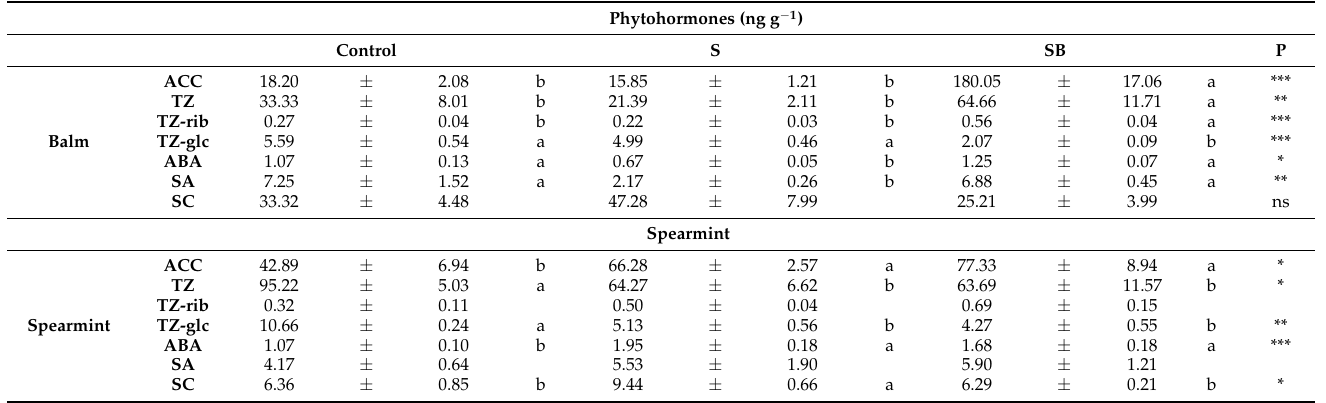
Table 3. Concentration of phytohormones in leaves of balm and spearmint plants irrigated with water with different sources at 15th day. Values are mean ± S.E. of six plants.